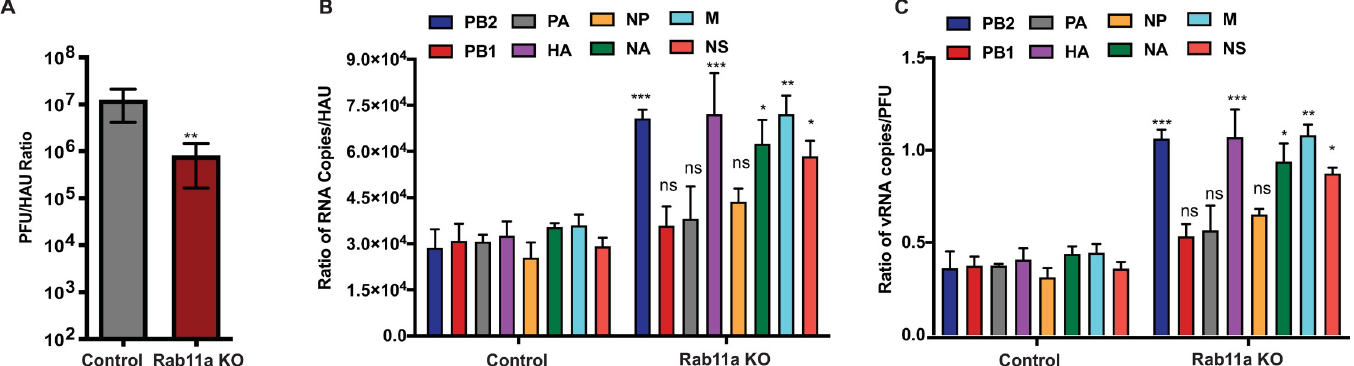
Fig 5. Absence of Rab11a results in defective genome assembly and increased production of defective particles. (A) Rab11a KO cells show increased production of non-infectious virus particles. Control A549 and Rab11a KO cells were infected with WT PR8 at MOI = 0.01 and viral titers in the supernatants were measured at 48 hpi by plaque assay. Hemagglutination titers were determined as HA units (HAU) using 0.5% chicken RBC. The ratio of PFU to HAU is shown. (B-C) Virions purified from Rab11a KO cells show increased defective particles. Control A549 and Rab11a KO cells were infected with WT PR8 (H1N1) for 72 hours, and virions in the supernatants were purified on a sucrose cushion. Viral genomic RNAs were reverse transcribed and individual segment copy numbers were quantified by digital droplet PCR. (B) Ratio of vRNA copy numbers to HAU. (C) Ratio of vRNA copy numbers to PFU. Ratios are shown for all eight PR8 segments. � p-value < 0.05; �� p-value < 0.01; ��� p- value < 0.001; N.S., non-significant. Data are representative of three replicates of virion preparations from control A549 and Rab11a KO